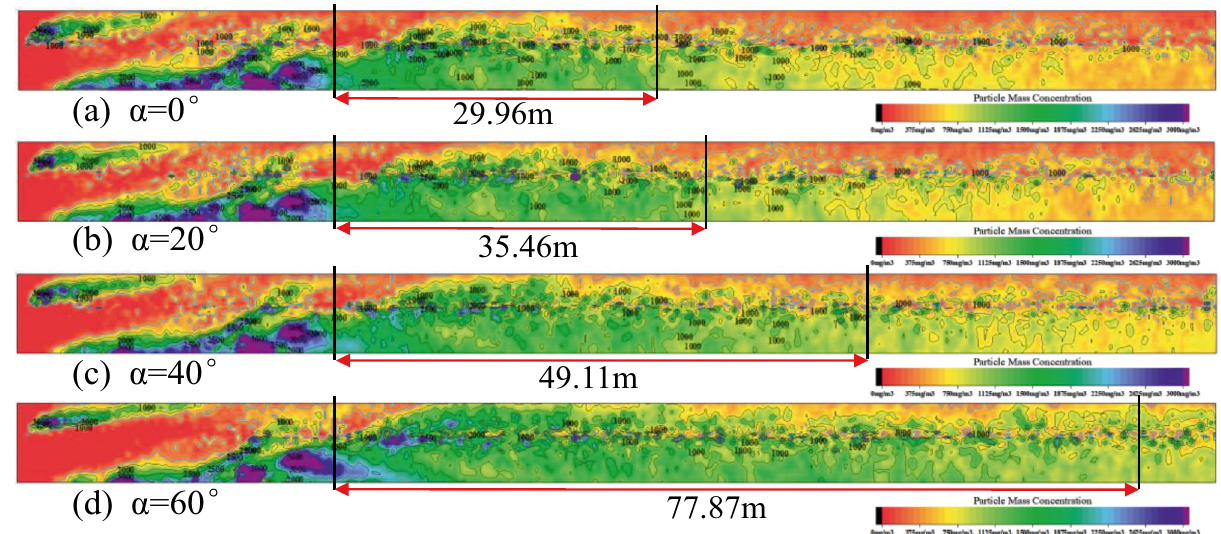
Figure 7. Contour map of dust mass concentration distribution at the height of the respiratory zone (α = 0°, 20°, 40°, cable trough is greater than the air velocity on the sidewalk, which is conducive to the diffusion of dust. With the continuous increase in the inclination of the working face, the tendency for the settlement of high- concentration dust clusters is significantly reduced. 2. When the inclination of the working face is 0°, a high-concentration dust cluster with an average dust mass concentration of 1064.26 mg/m 3 will form in the zone of X = 34.6–64.56 m, Y = 3.6–5.9 m, Z = 1.8–2.7 m; when the working face inclination is 20°, a high-concentration dust mass with an average dust mass concen- tration of 1098.44 mg/m 3 will form in the zone of X = 34.6–70.06 m, Y = 3.3–5.9 m, Z = 1.8–2.75 m; when the working face inclination is 40°, at X = 34.6–83.71 m, Y = 2.7–5.9 m, Z = 1.8–2.75 m, a high-concentration dust mass with an average dust mass concentration of 1108.28 mg/m 3 will be formed; at a working face inclination of 60°, at X = 34.6–112.47 m, Y = 2.3–5.9 m, Z = 1.8–2.8 m zone forms a high-concentration dust cluster with an average dust mass concentration of 1075.73 mg/m 3 . Hence, when the inclination of the working surface